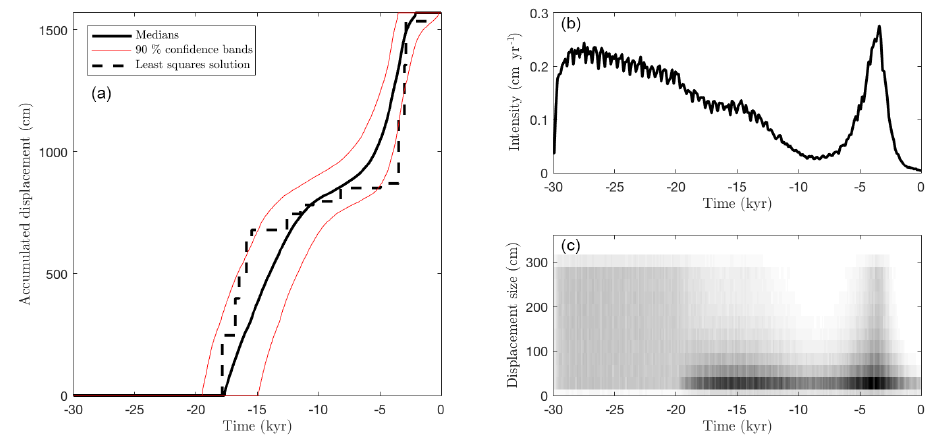
Figure 14. Frattura fault: the accumulated displacement (a) , the mean earthquake intensity (b) and an event scatter plot (c) showing events from posterior samples (with gray scale to indicate frequencies).